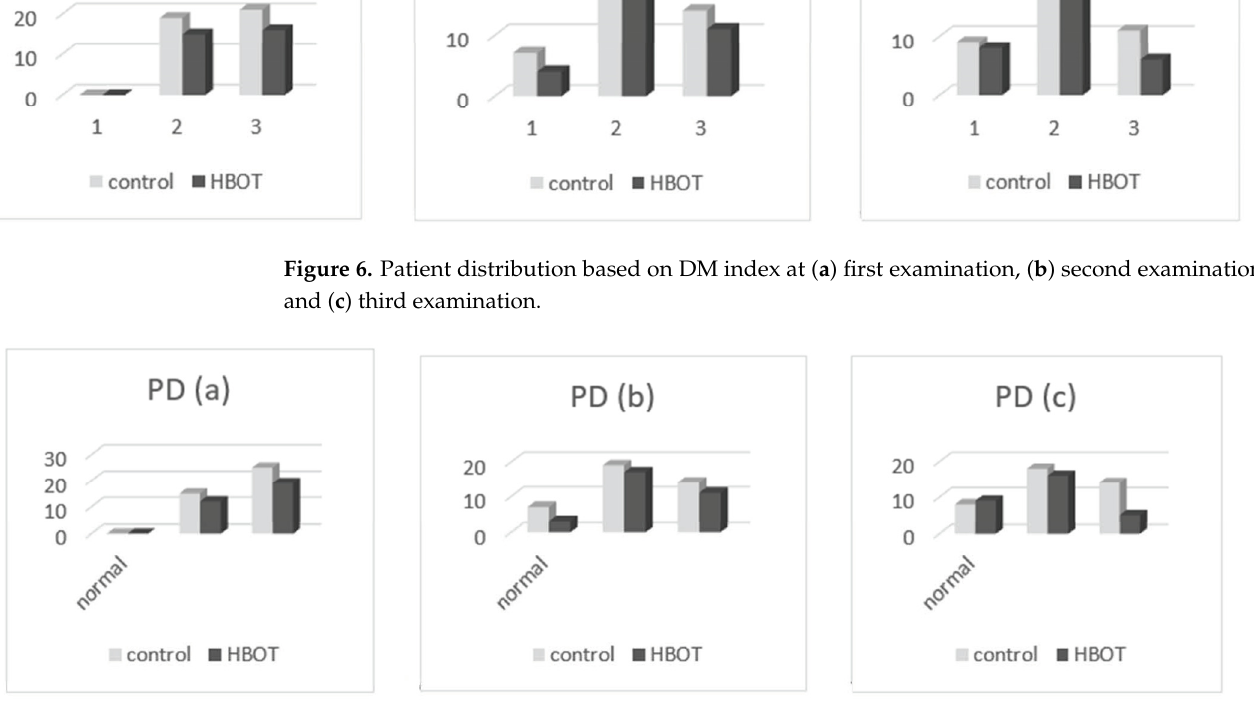
Figure 7. Patient distribution based on PD at ( a ) first examination, ( b ) second examination, and ( c ) third examination.